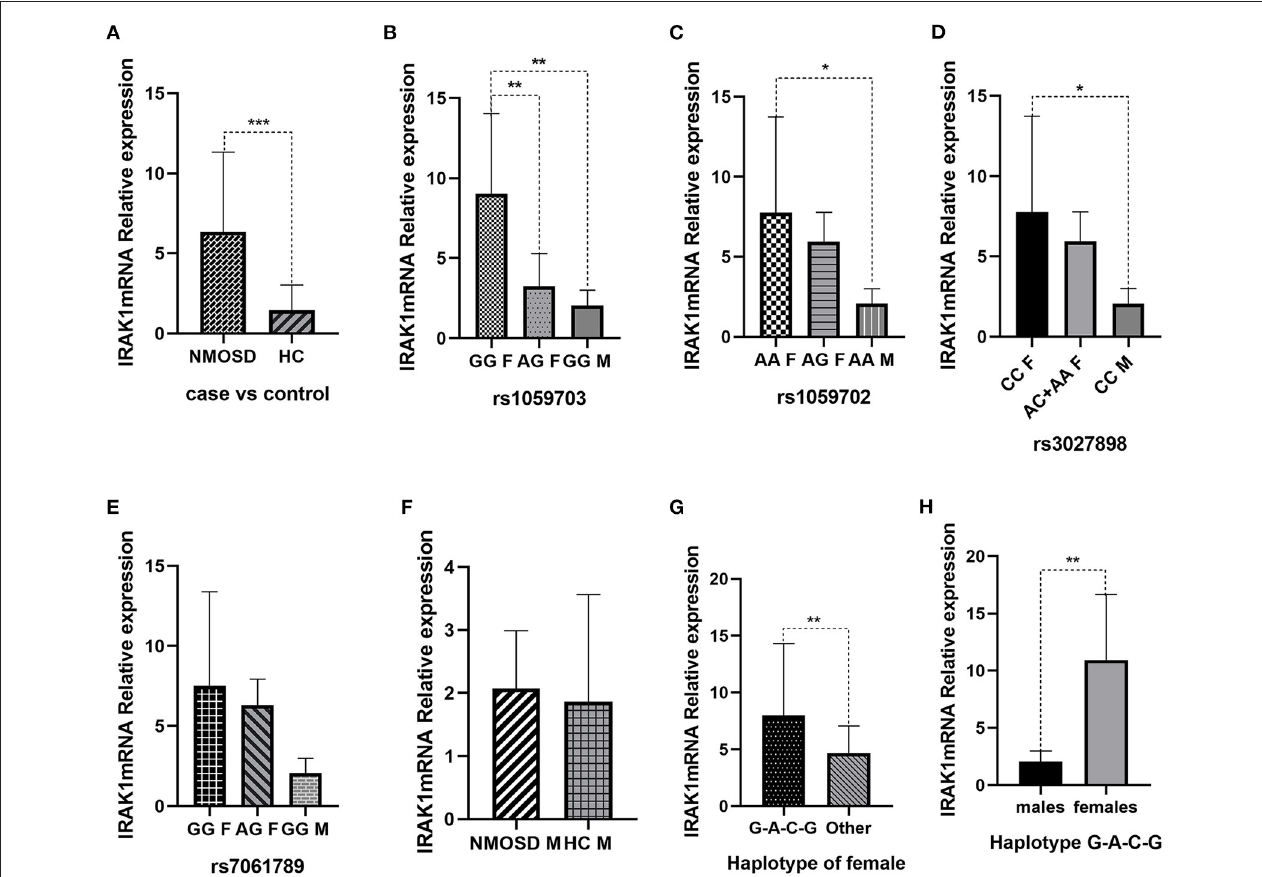
FIGURE 2 | (A) Expression of IRAK1 mRNA level in NMOSD case group and healthy control group. (B) Expression of IRAK1 mRNA level in NMOSD patients with different rs1059703 -genotypes. (C) Expression of IRAK1 mRNA level in NMOSD patients with different rs1059702-genotypes. (D) Expression of IRAK1 mRNA level in NMOSD patients with different rs3027898-genotypes. (E) Expression of IRAK1 mRNA level in NMOSD patients with different rs7061789-genotypes. (F) Expression of IRAK1 mRNA level in male NMOSD patients and male healthy control group. (G) Expression of IRAK1 mRNA level in female NMOSD patients with different haplotypes . (H) Expression of IRAK1 mRNA level in male and female NMOSD patients with the risk haplotype. * P < 0.05, ** P < 0.01, *** P <